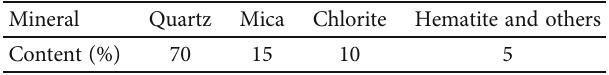
Table 4: The contents of main mineral composition